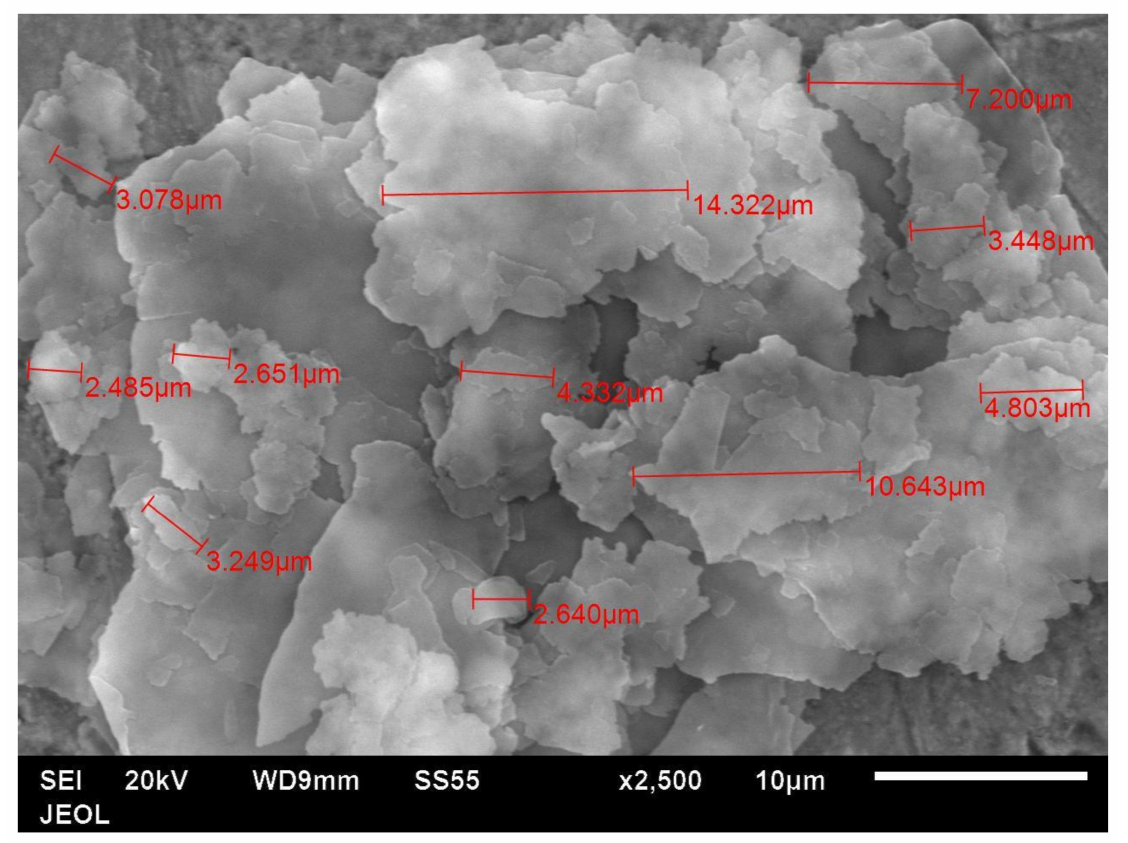
Figure 3. SEM image of Al 1 powder (Nanografi, Germany) shows flakes and their in-plane dimen- sions. The shapes are not polygonal, and they have rounded